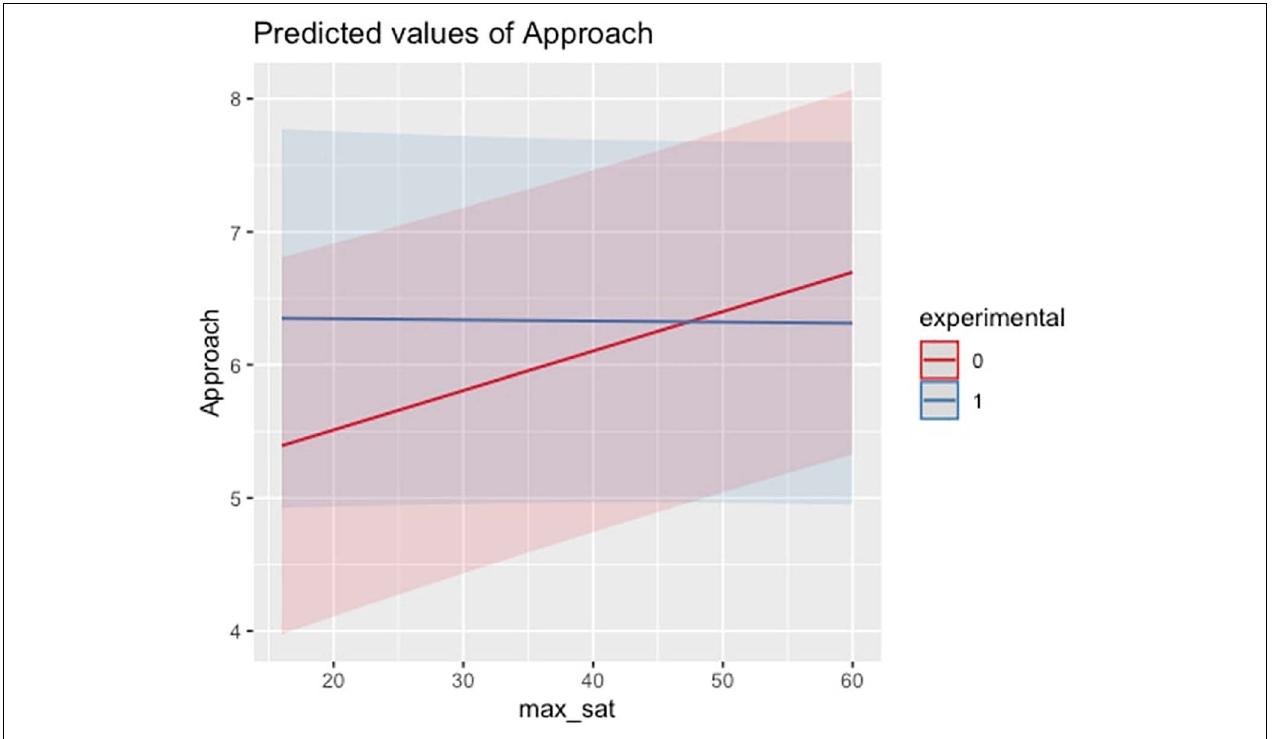
FIGURE 1 | Interaction effect for Approach Score and Maximization (satisficing subscale).